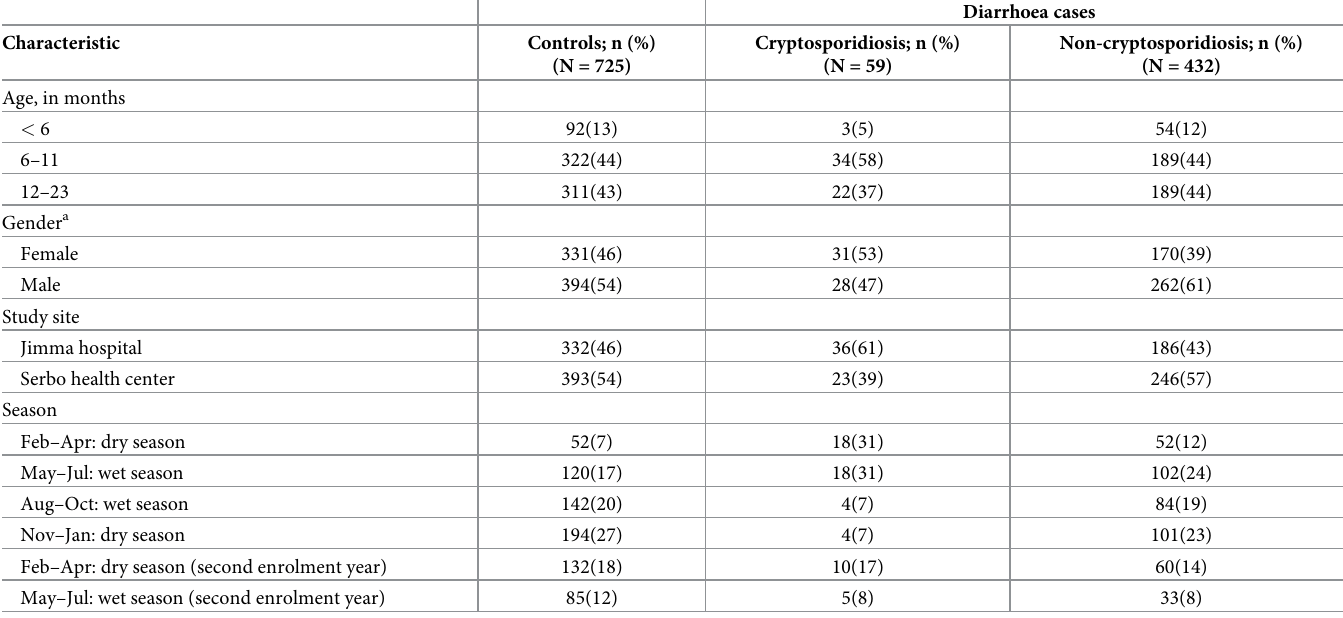
Table 1. Distribution of diarrhoea cases with and without cryptosporidiosis and non-diarrhoea controls, according to gender and a priori defined confounding demographic variables.